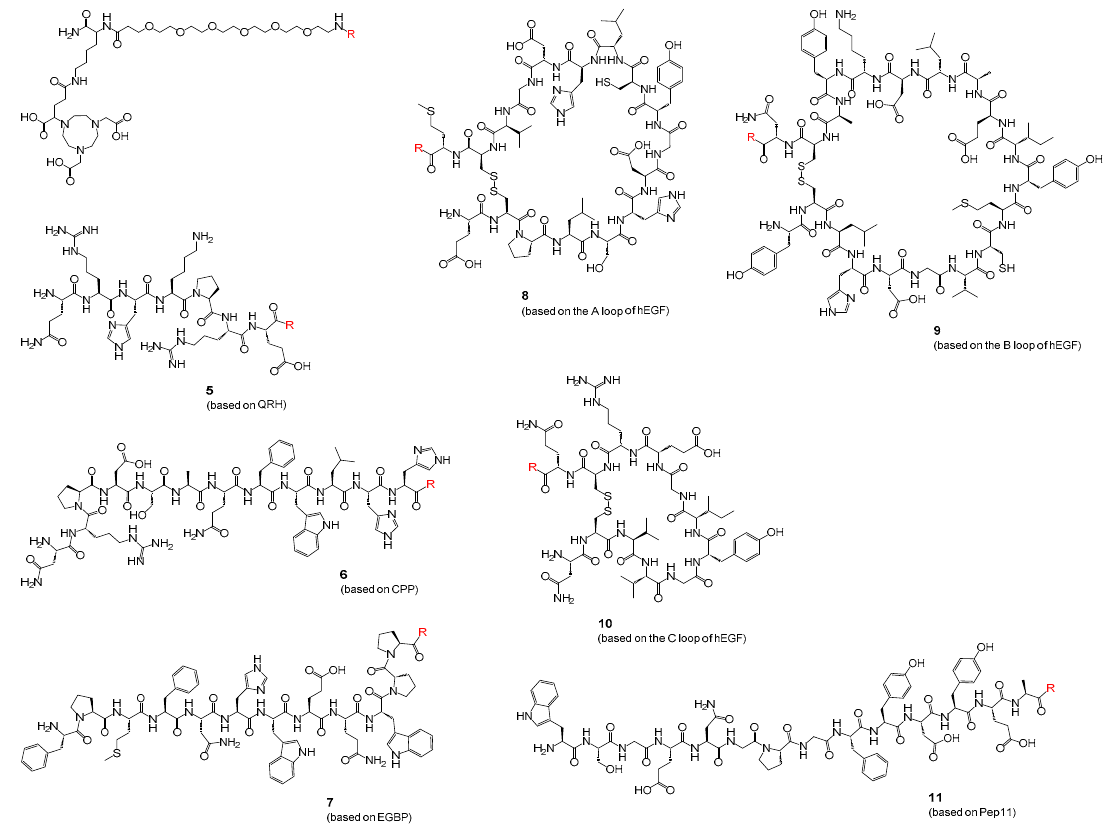
Figure 3. Structures of the C -terminally PEG 5 -NODA-GA-modified labeling precursors based on the peptides QRH ( 5 ), CPP ( 6 ), EGBP ( 7 ), the three loops of the hEGF ( 8 – 10 ) and Pep11 ( 11 ).